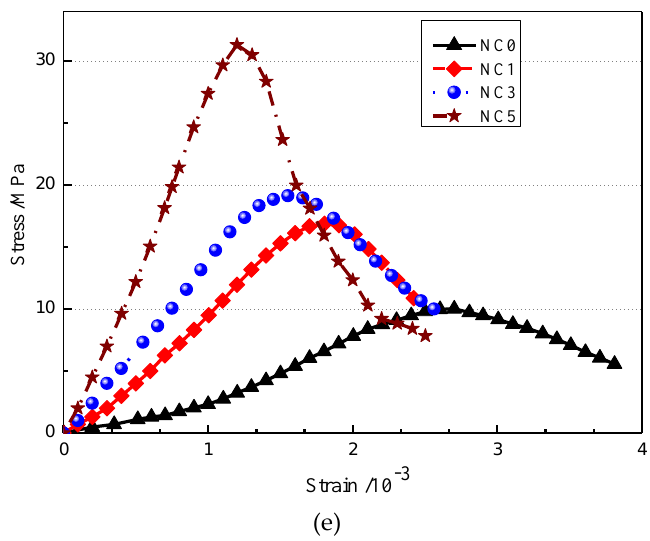
Figure 10. Stress-strain relationship of the concrete with various additions of NMK. ( a ) Freeze– thaw cycles: 0; ( b ) Freeze–thaw cycles: 25; ( c ) Freeze–thaw cycles: 50; ( d ) Freeze–thaw cycles: 100;